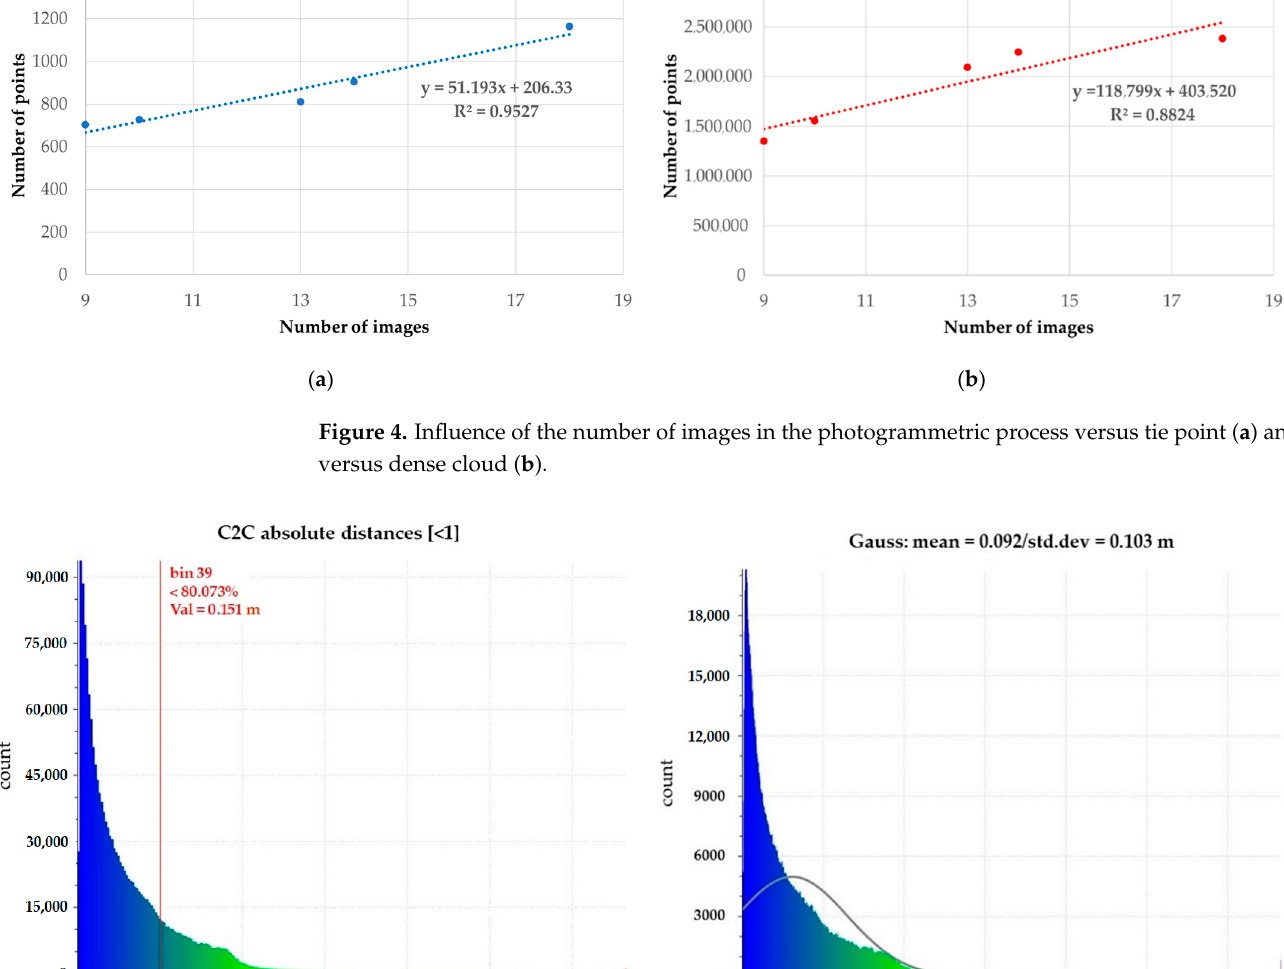
Figure 4. Influence of the number of images in the photogrammetric process versus tie point ( a ) and versus dense cloud ( b ).